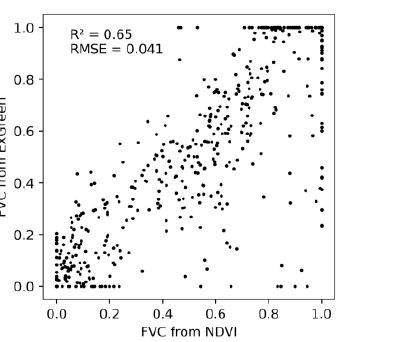
Figure 7. Relationship between calculated FVC from ExG/NDVI and FVC from field data (only herbs).